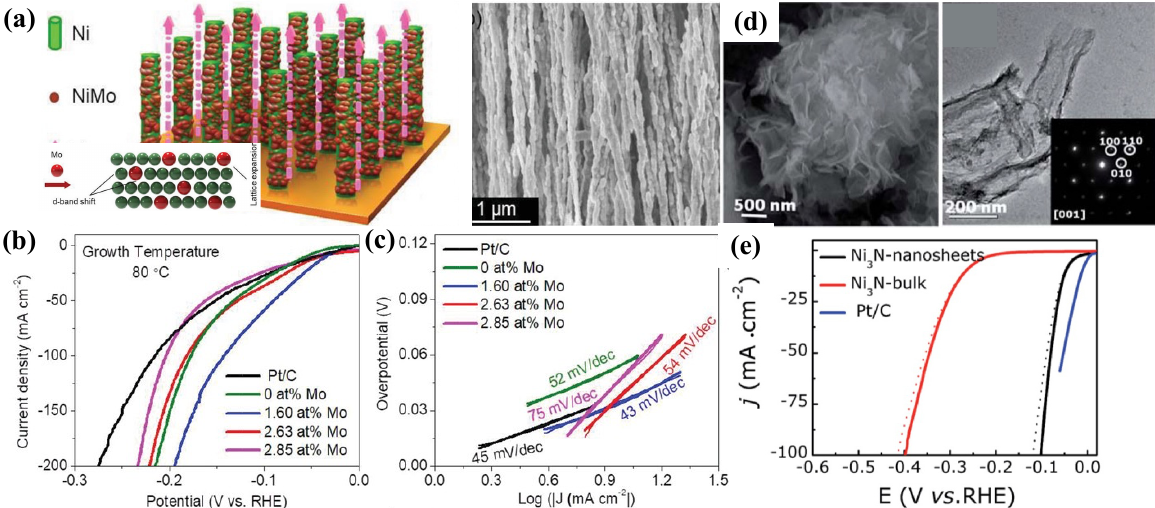
Figure 9. ( a ) Illustration of a schematic fabrication of NiMo nanowire arrays via magnetic field- assisted growth and SEM image. ( b ) LSV curves and ( c ) corresponding Tafel plot of NiMo nanowire arrays, NiMo-65; reprinted with permission from Ref. [66]. ( d ) SEM and TEM images and ( e ) polar- ization curves of Ni 3 N nanosheets with a scan rate of 2 mV s − 1 ; reprinted with permission from Ref. [67].